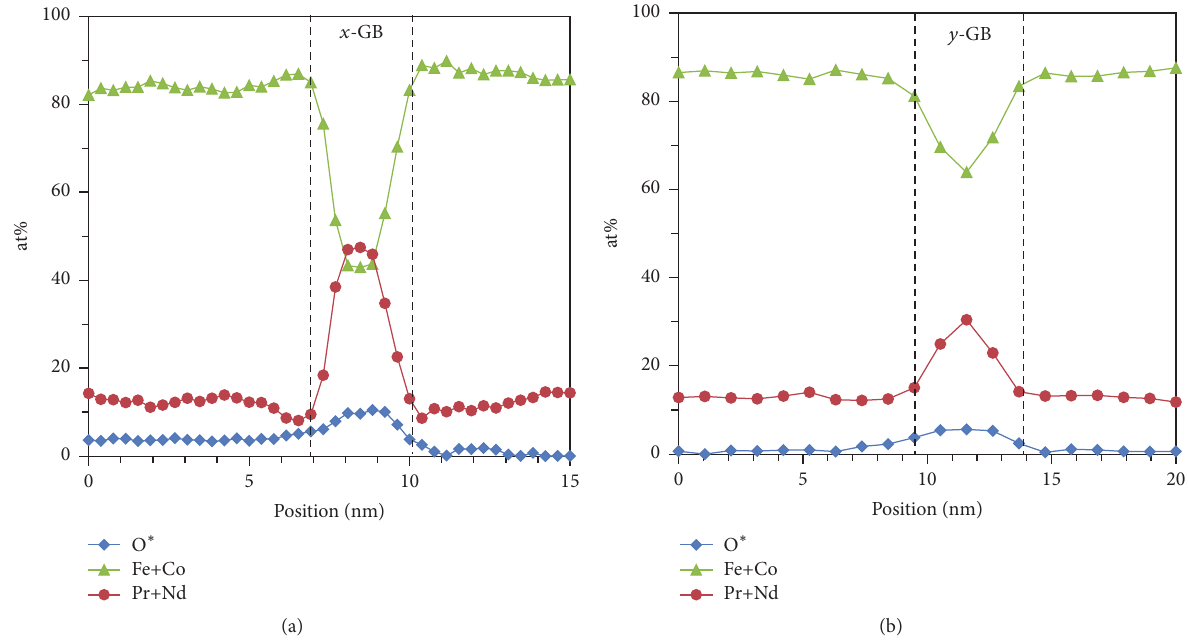
Figure 9: EELS line scans across 𝑥 -GB (a) and 𝑦 -GB (b) of the elongated grain of Figure 8(b); significant difference in the chemical composition of 𝑥 - and 𝑦